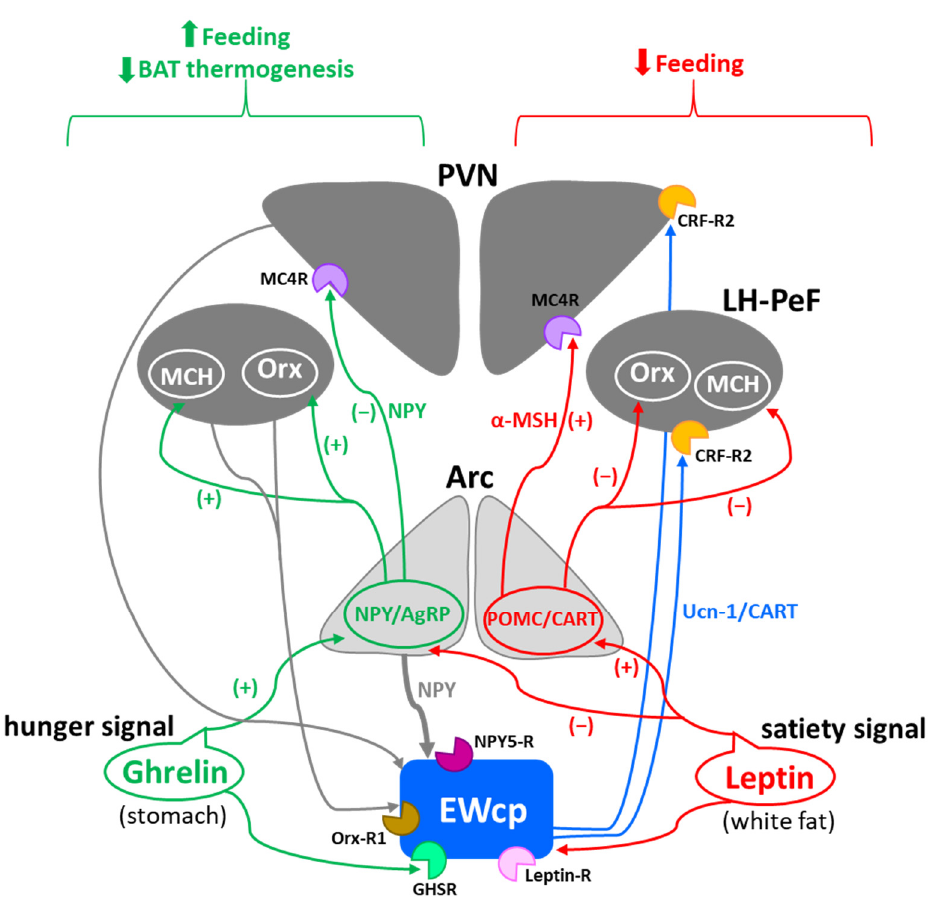
Figure 9. Connections of EWcp with the hunger–satiety circuit. EWcp receives a substantial projection from Arc and has reciprocal connections with PVN and LH-PeF. EWcp neurons express receptors for leptin (satiety signal) and ghrelin (hunger signal), and for the main neurotransmitters involved in this pathway (NPY, Orx, and probably MCH), suggesting that it could modulate energy expenditure by virtue of interacting with key elements of the hunger–satiety circuit. For the sake of clarity, hunger and satiety pathways are depicted unilaterally, as well as EWcp afferent and efferent projections, although all these pathways are bilateral. For terms, see the list of abbreviations.